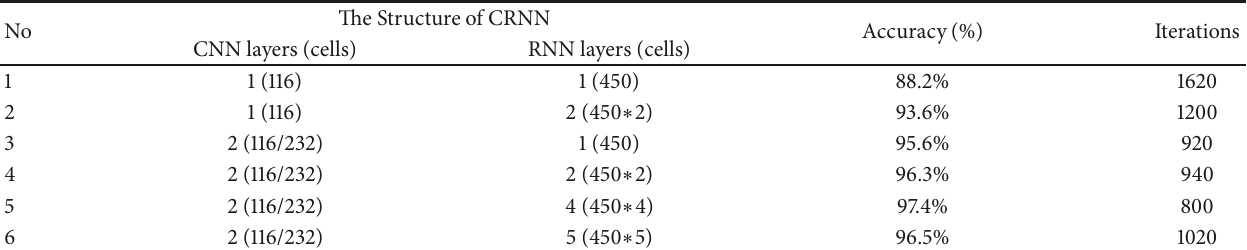
Table 3: Result of the CRNN models with different layer in the structure